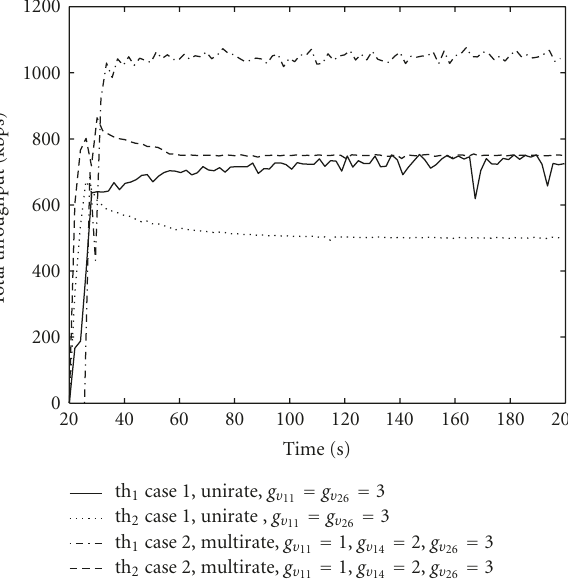
Figure 14: Case 2 (multirate): calculated rate and throughput using gateway node υ 14 for rate control on m 1 .